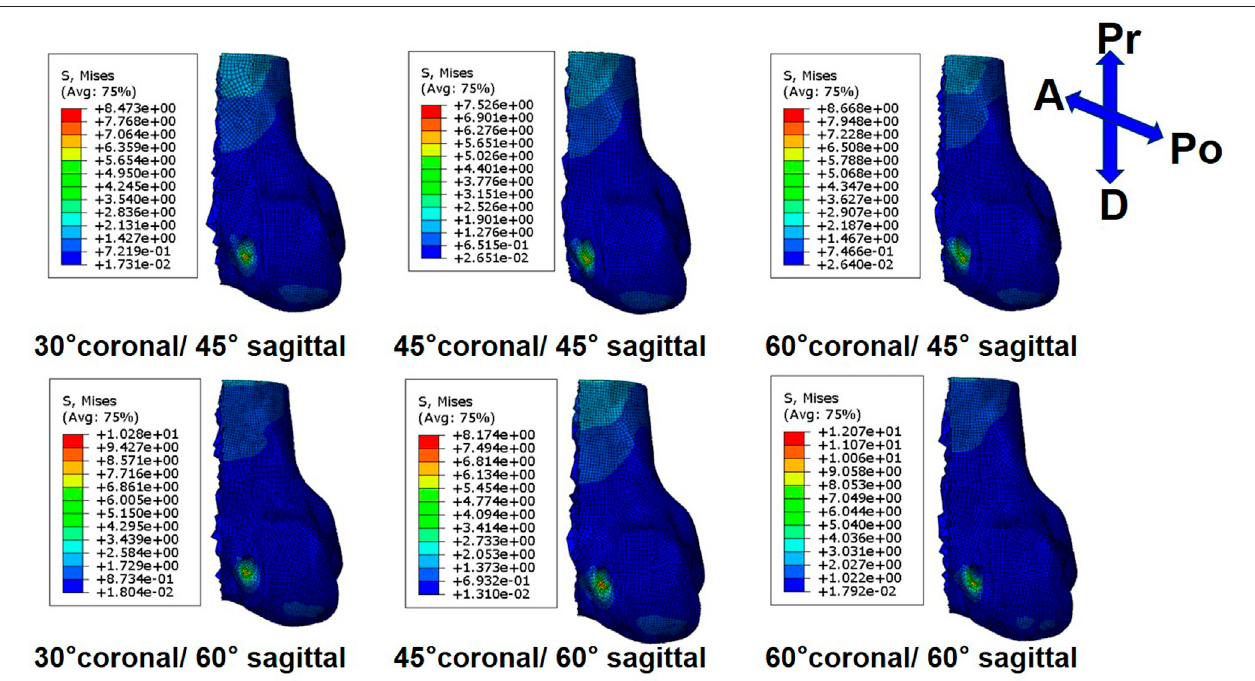
FIGURE 4 | Stress distribution around femoral tunnel entrance following